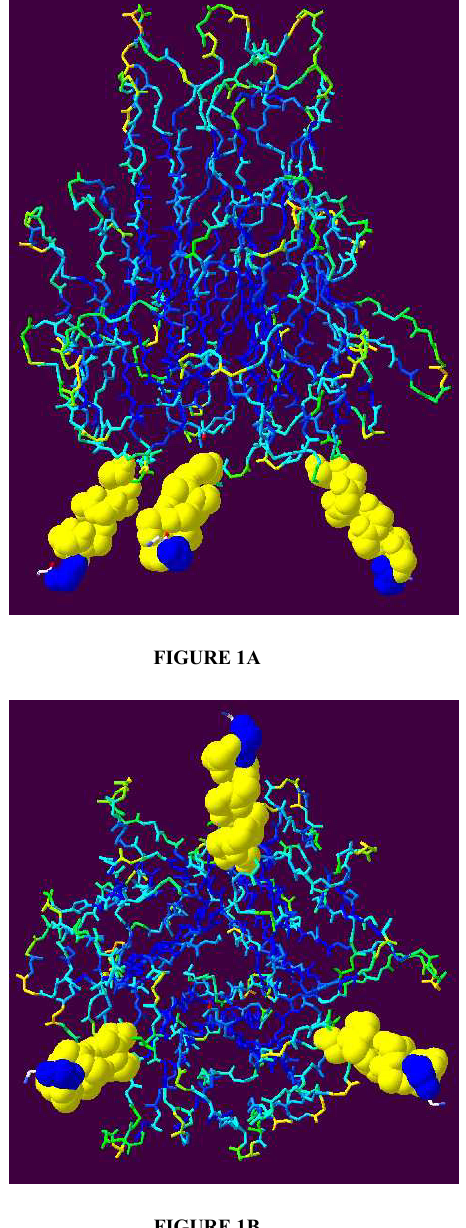
FIGURE 1. Model of His7-( ∆ N6)TNF. (A) Side view. (B) Bottom view. Tags are colored as in Table 4. Histidines and hydrophobic amino acid residues are in yellow, while hydrophilic (charged and polar) residues are in blue. Protein backbone is colored by accessibility: blue (interior) and green/yellow